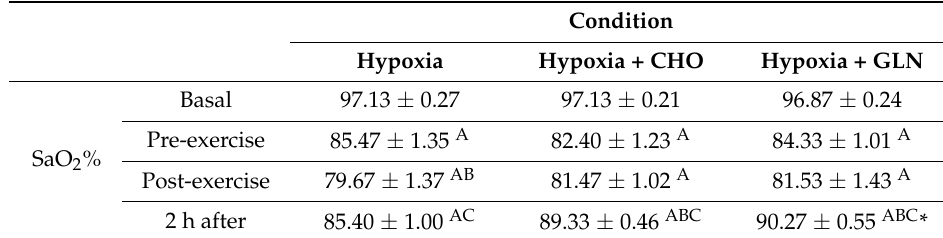
Table 1. O 2 saturation percent (SaO 2 %).